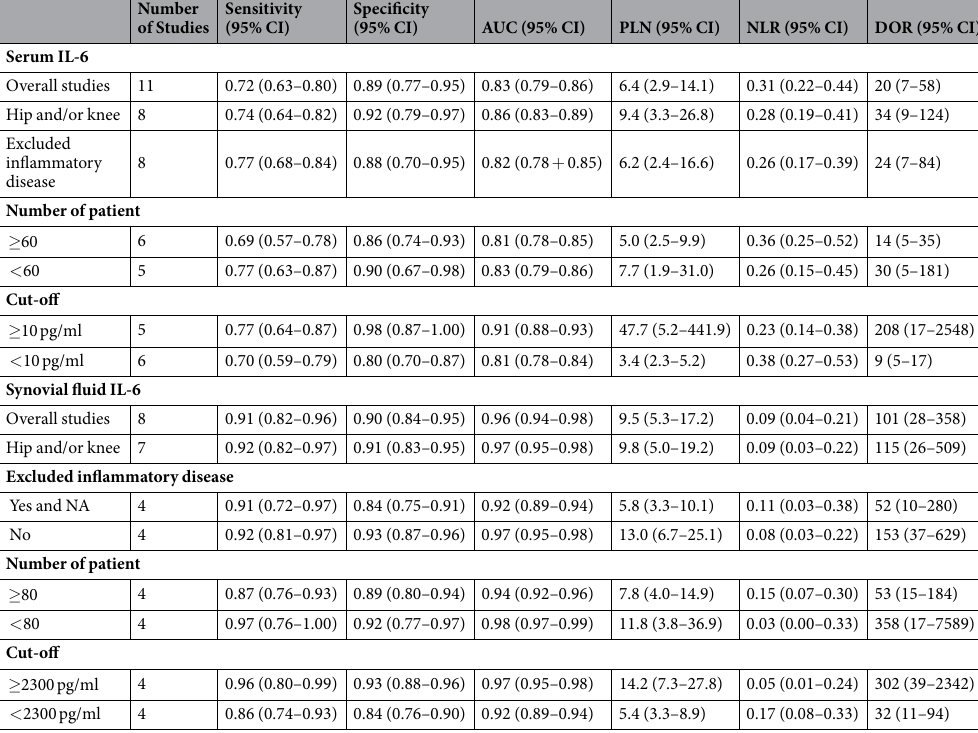
Table 2. Subgroup analysis of serum and synovial fluid IL-6 for PJI